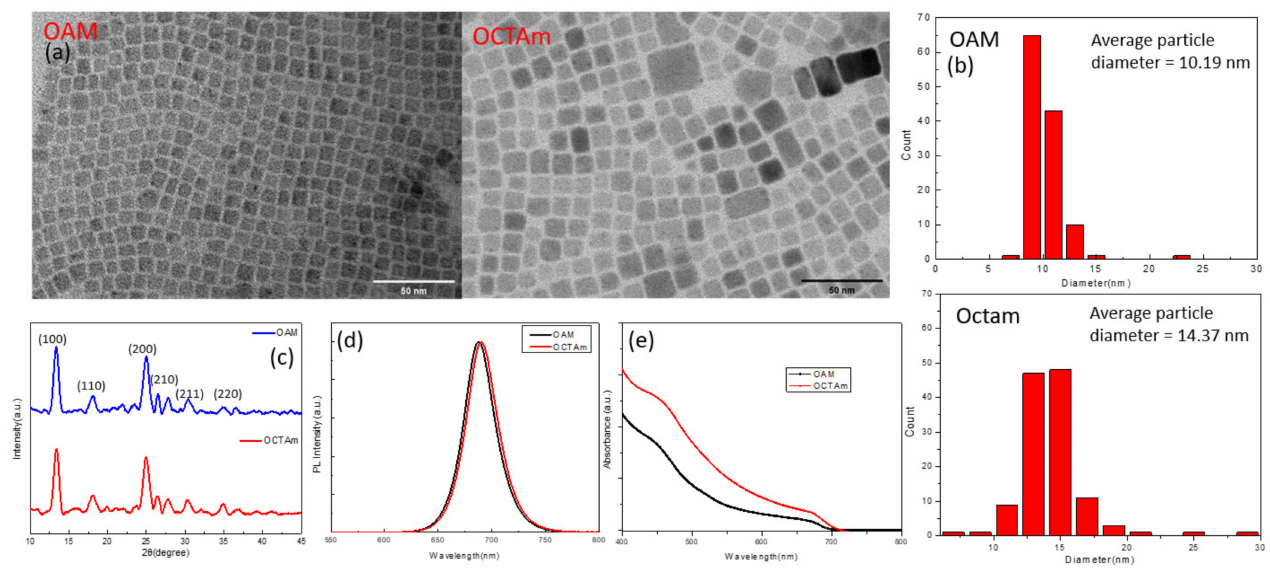
Figure 1. ( a ) TEM images and ( b ) size distribution for QD films; ( c ) XRD pattern of CsPbI 3 QDs; ( d ) PL spectrum and; ( e ) UV–vis absorbance spectra for QD